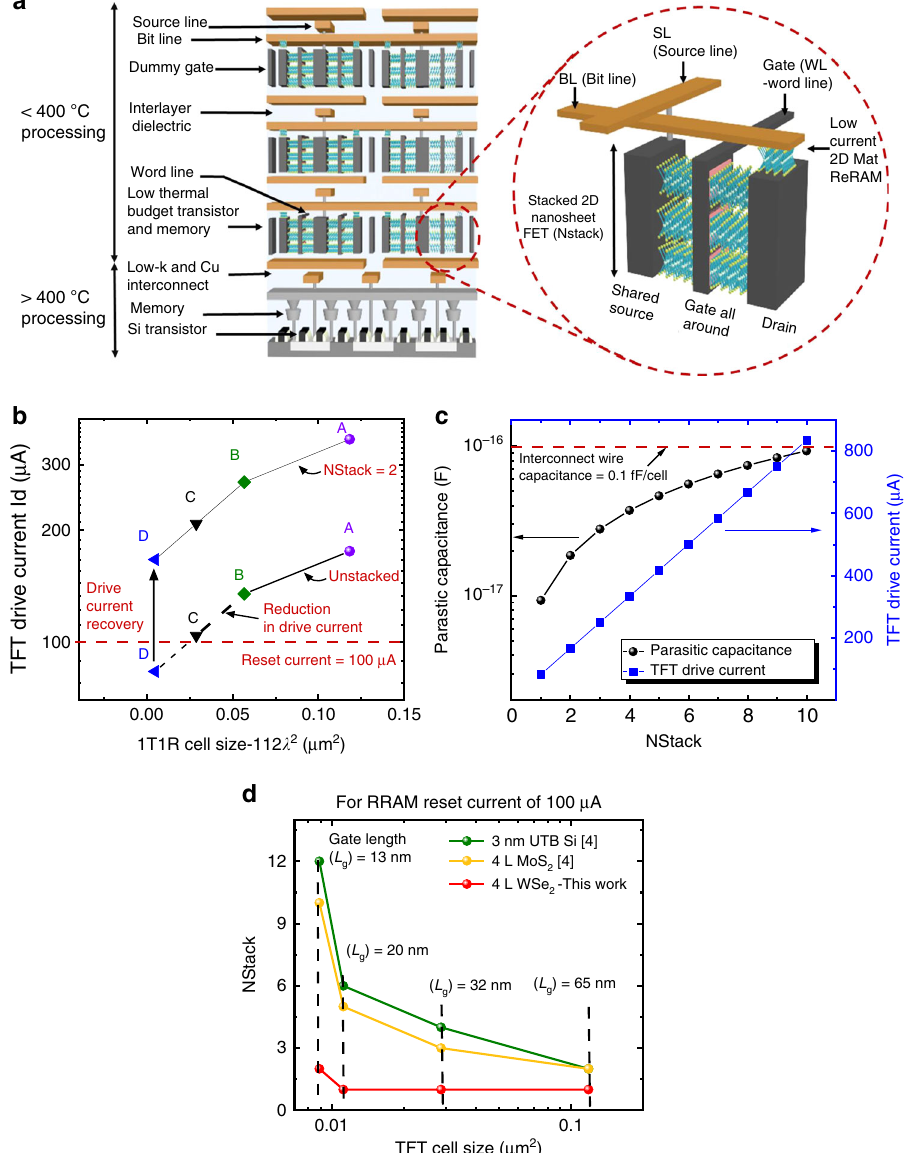
Fig. 6 3D monolithic stacking of TFT and memory. a Conceptual illustration of 3D monolithic stacking of CMOS logic and 2D multiple-stacked WSe 2 TFTs with ReRAM with thermal budget indicated for various levels (not to scale). b Transistor drive current (at V sg = 2 V) variation with respect to 1T1R cell size as per λ design rule. The speci fi cations for the legends are, A: L g = 65 nm , W ch = 130 nm, EOT = 2.3 nm, k = 4.5 ; B: L g = 45 nm, W ch = 90 nm, EOT = 2.2 nm, k = 4.5; C: L g = 32 nm, W ch = 64 nm, EOT = 2.1 nm, k = 4.5; D: L g = 13 nm, W ch = 26 nm, EOT = 1.1 nm, k = 25. We observe ~2.25× drop in drive current as the width is scaled 5× (130 – 26 nm). Stacked-channel devices showing the recovery of drain current with NStack = 2, to support the ReRAM reset current of 100 µ A. c Change in TFT drive current and parasitic capacitance (self-capacitance due to stacking) vs. NStack (number of 2DMat nanosheet stacking layer) at V sg = 2 V. d Comparison of NStack (number of nanosheet TFT stacked) for different feature sizes among WSe 2 , MoS 2 ,